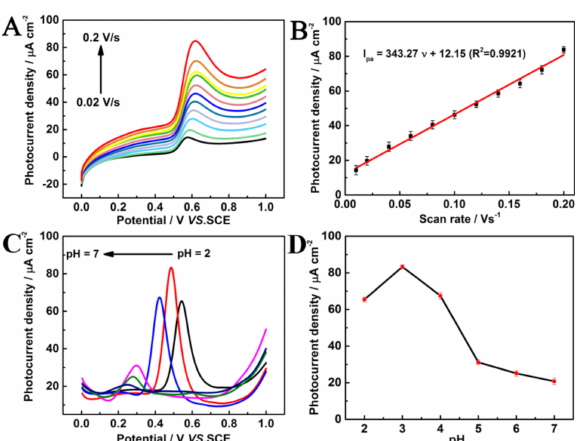
Figure 4. ( A ) Linear sweep voltammetry (LSVs) of Au / NGQD electrodes in 0.1 M BR bu ff er solution (pH = 3.0) containing 0.5 mM CA in the scan rates ranging from 0.2 to 0.02 V s − 1 under visible-light illumination. ( B ) The calibration curves of photocurrent density responses versus the scan rates. ( C ) CVs of the Au / NGQD electrodes in 0.1 mM CA, with pH values ranging from 2.0 to 7.0. ( D )